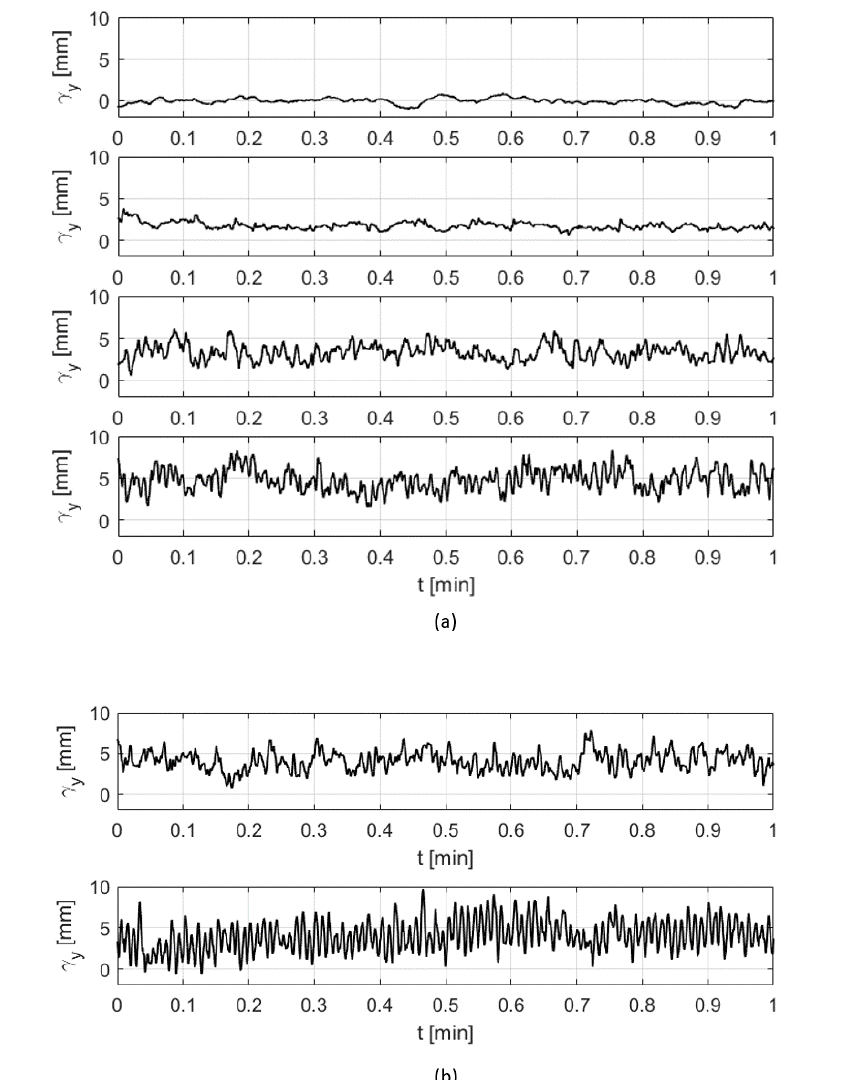
Figure 6. Deflection responses of a selected whisker tip due to the existence of the cylinder at different locations ( a ) variation of the tip’s deflection response due to different x -coordinate locations of the cylinder. The curves from top to bottom represent the following cases respectively: no cylinder (reference case), cylinder positions: ( − 5,75), (0,75), (5,75). ( b ) variation of the tip’s deflection response due to different y -coordinate locations of the cylinder. The curves from top to bottom represent the following positions of the cylinder, respectively: (5,85),